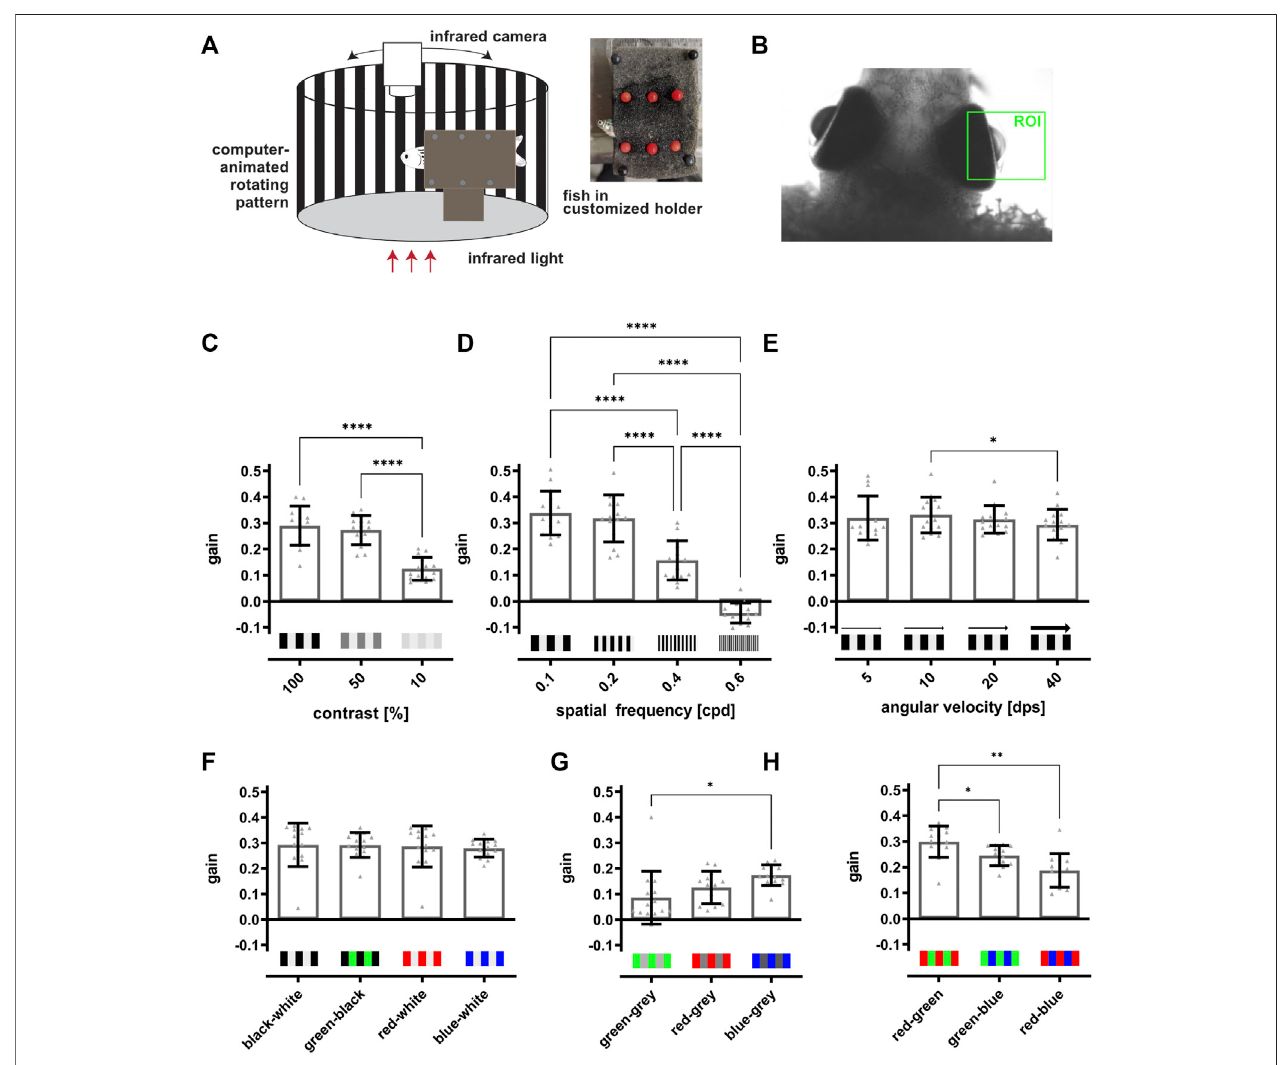
FIGURE 4 | The optokinetic response of adult zebra fi sh is dependent on contrast, spatial frequency and color of the stimulus. (A) Scheme of the optokinetic response(OKR)setup.Utilizingacustomizedholder (inset),atest fi shisplacedinthemiddleofaroundarenainwhichacomputer-animated stimulusisprojectedontoa white drum surrounding the fi sh. The movement of the eyes is recorded from the top using an infrared-sensitive camera and an infrared light source placed beneath the fi sh. (B) Representative image of a fi sh placed in the OKR setup. The region of interest (ROI) for tracking the movements of the right eye is indicated in green. (C) Quanti fi cation ofthegainobtainedwith100,50,and 10%contrastshowedthatthevaluesfor100and 50%contrast(0.29 ± 0.07and 0.27 ± 0.05)arehighly similar and are signi fi cantly increased in comparison to the value for 10% contrast (0.12 ± 0.04). (D) Quanti fi cation of the gain dependent on the spatial frequency revealed a signi fi cant drop from 0.1 (0.34 ± 0.08) over 0.2 (0.32 ± 0.09) and 0.4 (0.16 ± 0.07) to 0.6 cpd ( − 0.04 ± 0.04). (E) Quanti fi cation of the gain in dependence on angular velocity indicated no changes of the gain when the angular velocity was increased (5 dps: 0.32 ± 0.09, 10 dps: 0.33 ± 0.07, 20 dps: 0.31 ± 0.05, 40 dps: 0.29 ± 0.06). (F) Quanti fi cation showed that the gain is similar when black-white (0.29 ± 0.08), green-black (0.29 ± 0.05), red-white (0.29 ± 0.08) or blue-white stripes (0.28 ± 0.03) wereused. (G) Matchingthebrightnessofeachgreyleveltothebrightnessoftherespectivecolorresultedinanoveralllowergaincomparedtocoloredstripesonablack or white background. Blue-grey stripes elicited a signi fi cantly higher gain as compared to green-grey stripes (green-grey: 0.09 ± 0.01, red-grey: 0.13 ± 0.06, blue-grey: 0.17 ± 0.04). (H) Quanti fi cation revealed that two colored stimuli result in highest gains for red-green (0.3 ± 0.04), followed by green-blue (0.24 ± 0.04) and red-blue (0.19 ± 0.06).Statistics: alldataarerepresentedasmean ± SD, one-wayANOVA withTukey ’ smultiplecomparison test, p < 0.05(*);0.01(**); 0.001(***)or0.0001(****).